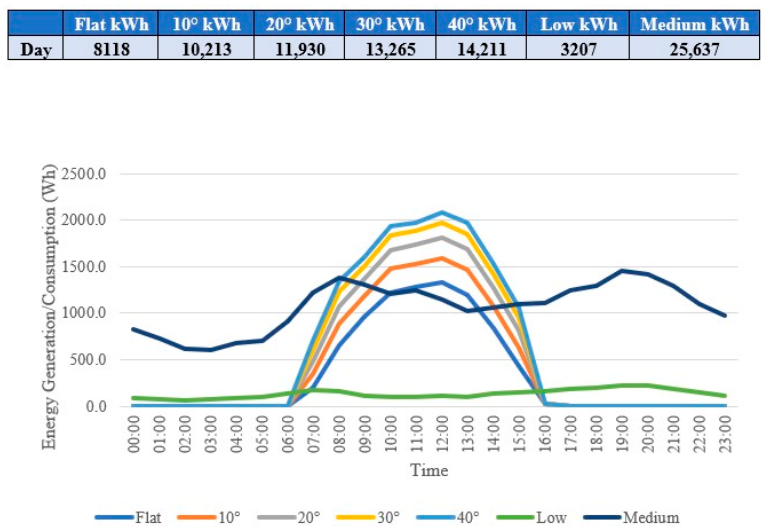
Figure 10. Comparison between hourly electricity generation of a 3 kWp PV system and the patterns of low-, and medium-consumption households for a south-facing system in November.